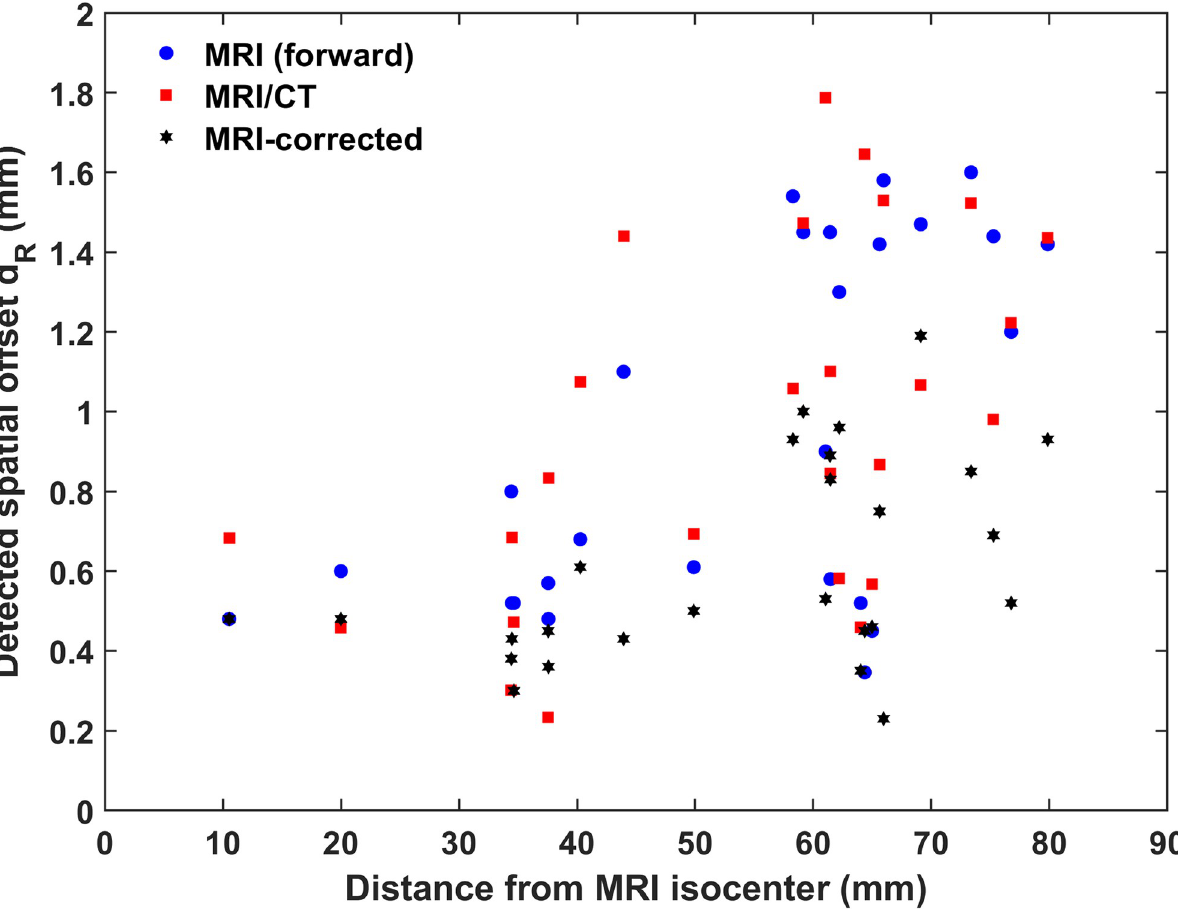
Fig 3. Magnitude of the radial spatial offset, | d |, for all 26 control points with respect to their distance from the MRI isocenter. Using Spearman’s R correlation coefficient, a statistically significant positive correlation between the distance to the MRI isocenter and detected radial offset was revealed for all three datasets.